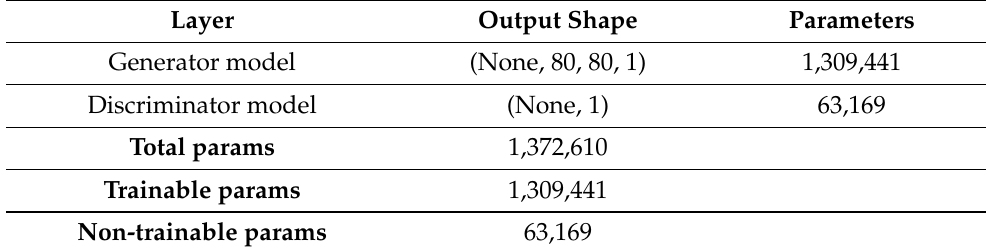
Table 8. Structure of the GAN model.